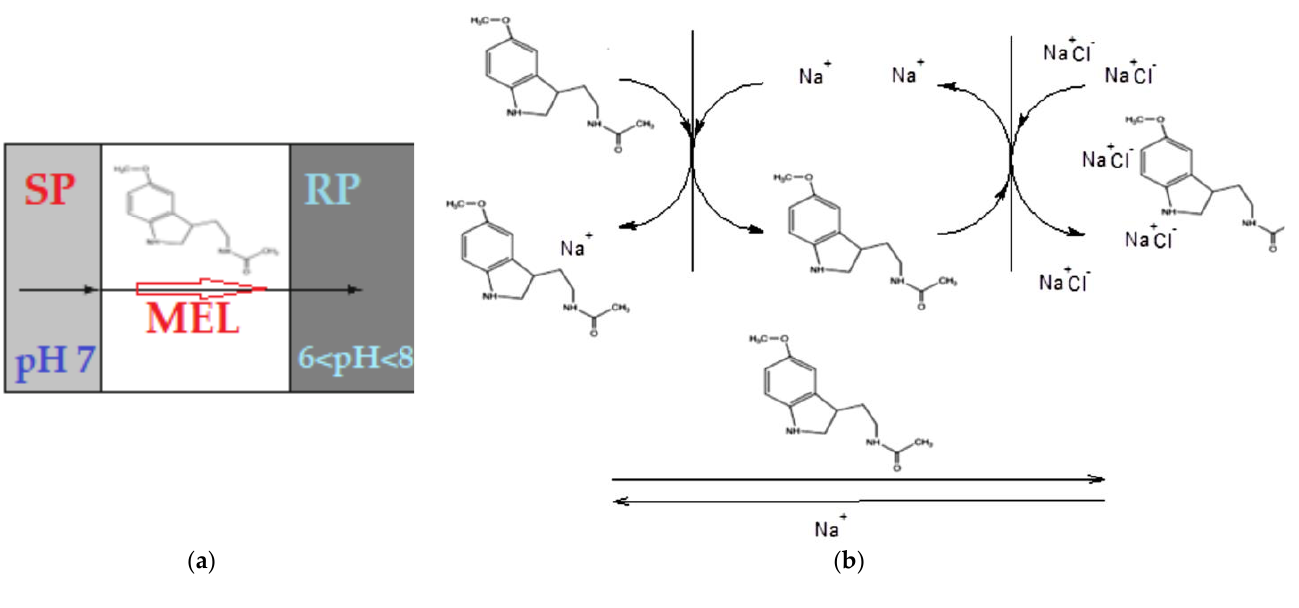
Figure 14. Transport schemes in the case of the receiving phase of controlled pH ( a ) or imposed salinity ( b ).